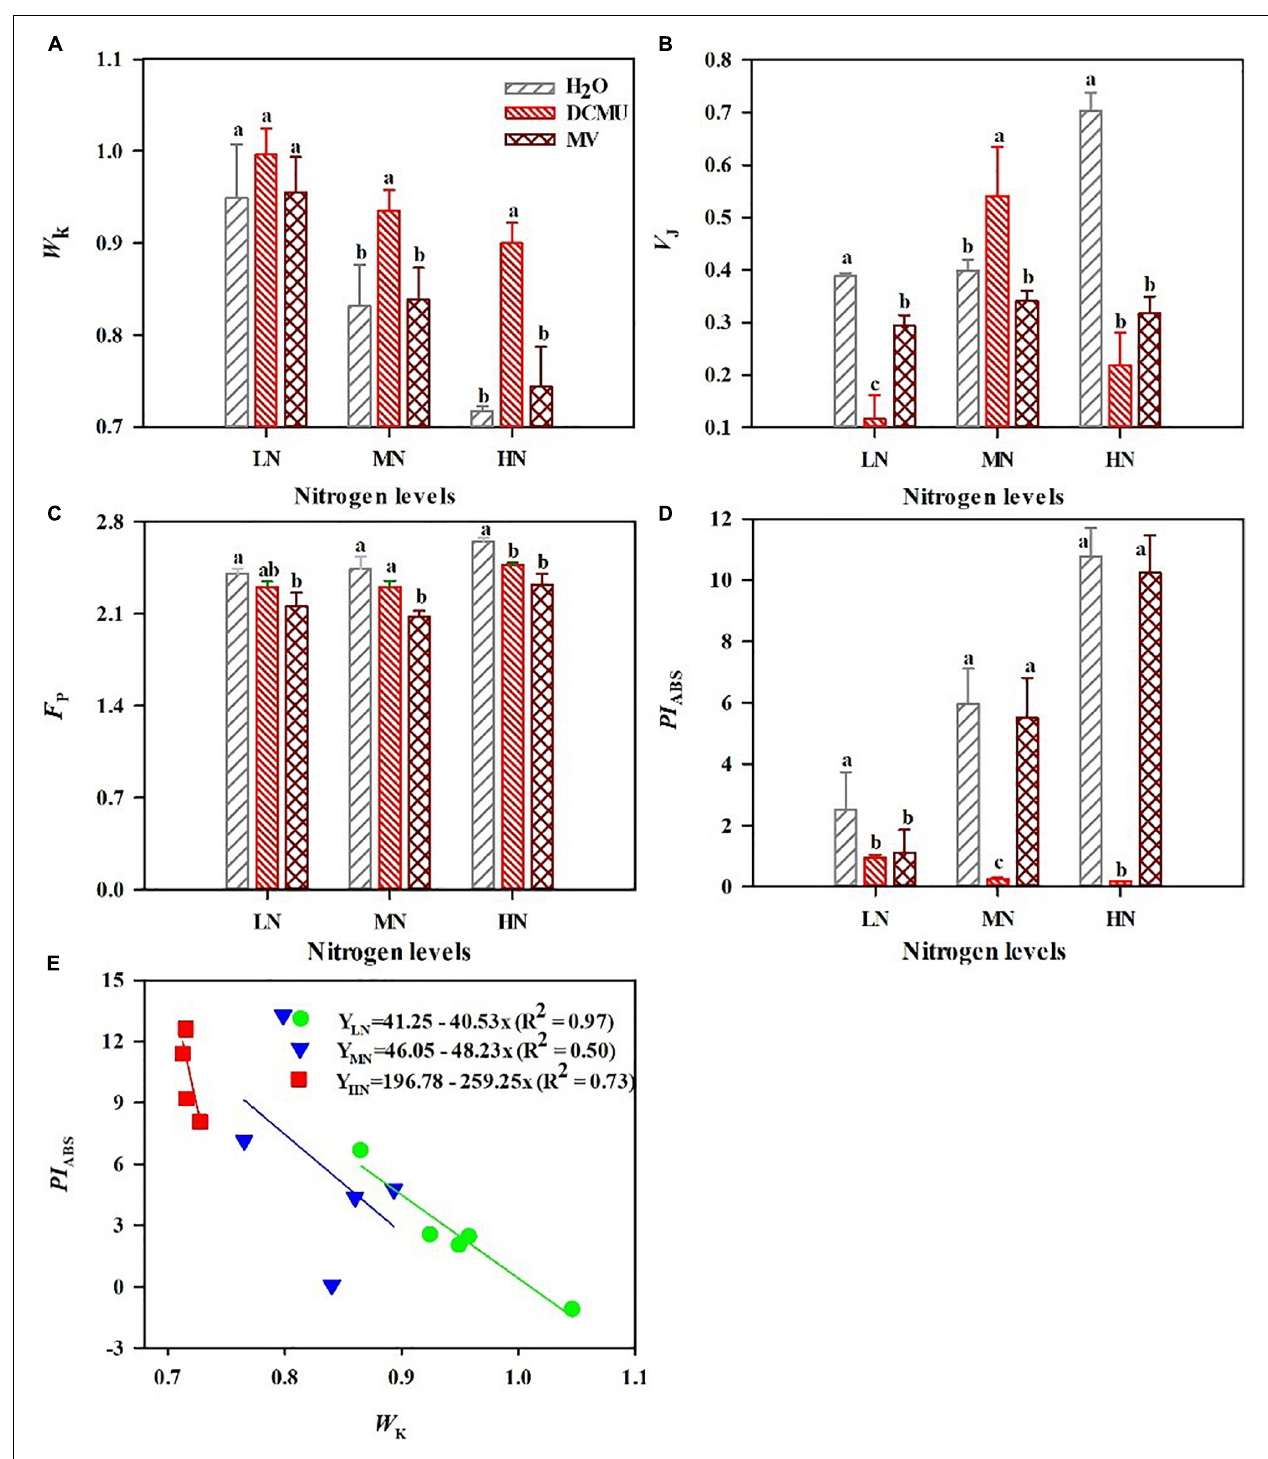
FIGURE 6 | Effects of 3-(3,4-dichlorophenyl)-1,1-dimethyl urea (DCMU) and methyl viologen (MV) on W K (A) , V J (B) , F P (C) , and PI ABS (D) in leaves of Panax notoginseng grown under different nitrogen regimes. W K is the K phase in OJIP kinetic curves (A) ; V J is the relative variable fluorescence intensity at the J-step (B) ; F P is the fluorescence intensity at the P-step (C) ; PI ABS is the performance index on absorption basis (D) . Values for each point were mean ± SD ( n = 5). (E) Figures represent the correlation between PI ABS and W K . Letters indicate significant differences at p < 0.05 according to Duncan’s multiple range tests.